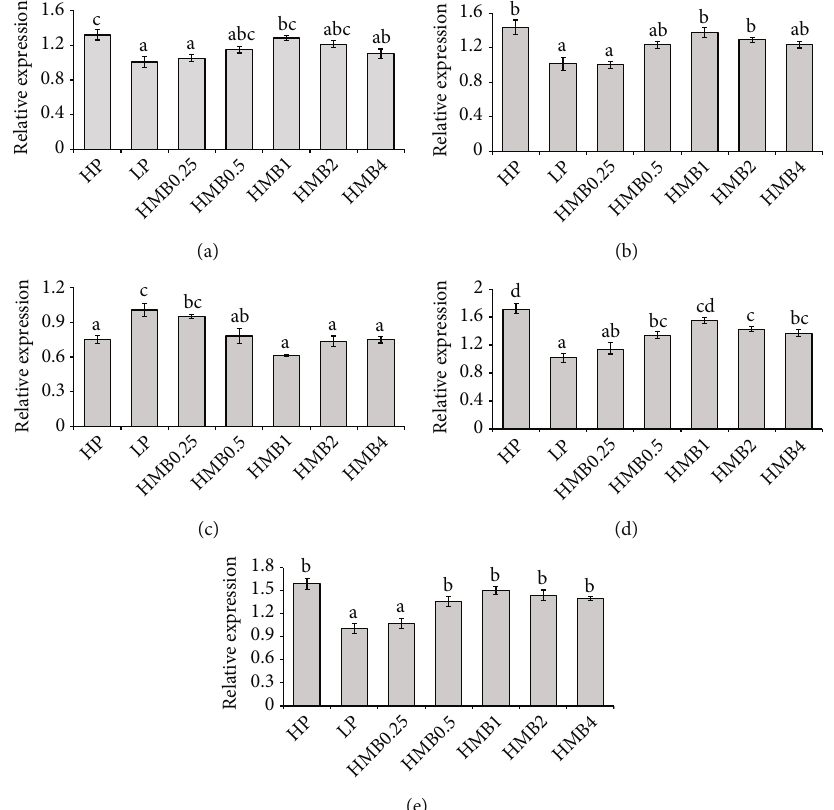
Figure 2: The relative mRNA expressions of tor (a), s6k (b), 4e-bp1 (c), pi3k (d), and akt (e) in muscle of kuruma shrimp fed with the experimental diets. Values are expressed as the means ± SE ( n = 3 ). Di ff erent lowercase letters above the bars present signi fi cant di ff erences ( p < 0 : 05 ). tor : target of rapamycin; s6k: ribosomal protein S6 kinase; 4e-bp1: eukaryotic translation initiation factor 4E (eIF4E)-binding protein 1; pi3k : phosphatidylinositol 3-kinase; akt : serine/threonine-protein